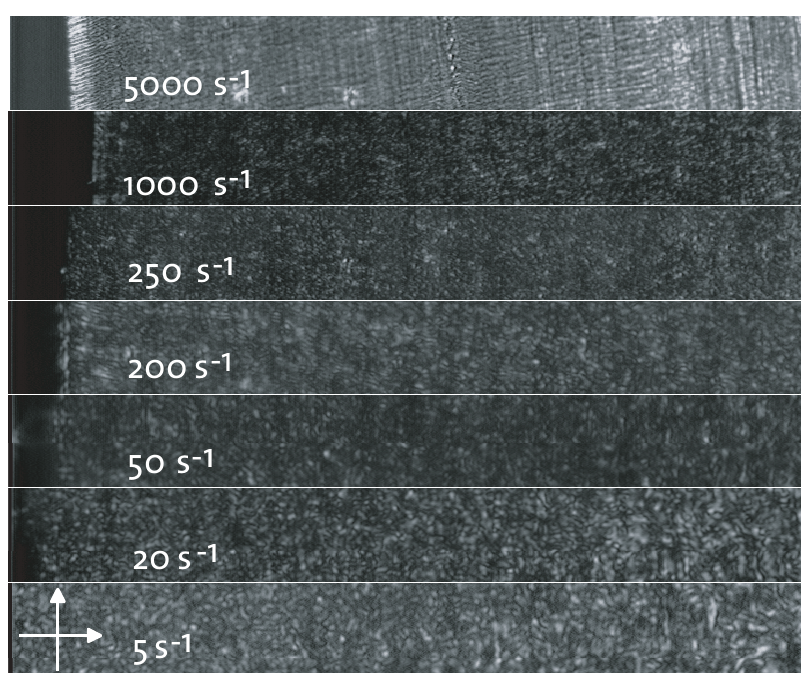
Figure 12: Shear induced texture development subjected to shear rates for Vectra B 950 (between crossed